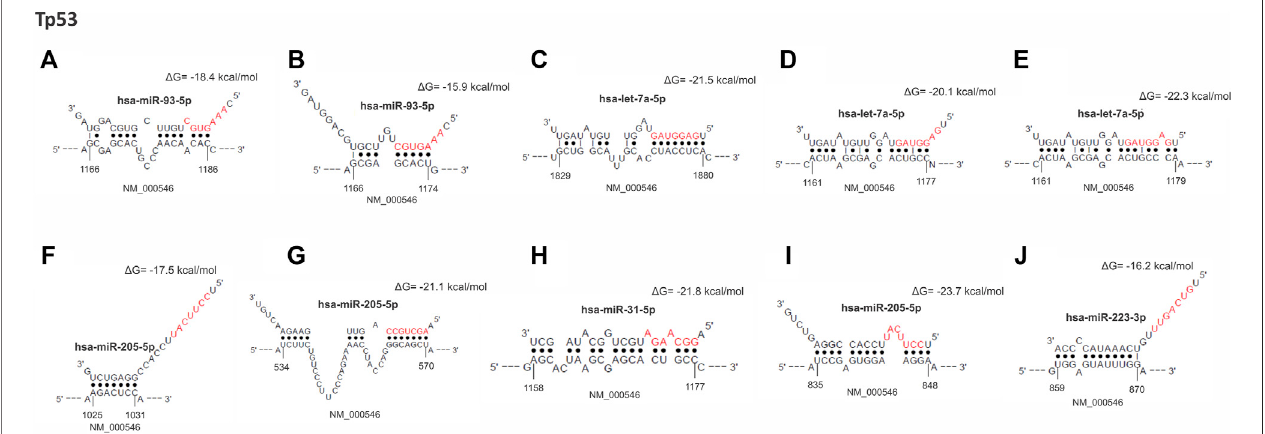
FIGURE 2 | From (A – J) , hybrid mRNA ( TP53 ) — miRNA upregulated. The upper and lower sequences represent the miRNA in the 3 ′ -5 ′ sense and 5 ′ -3 ′ sense hybridization sites in the mRNA, repectively. The numbers at the ends of the mRNA show the starting and ending position of the hybridization sites. Dots between the sequences indicate the paired nucleotides. Nucleotides in red mark the “ seed ” sequence in miRNA. The energy resulting from the hybridization was calculated by the RNA hybrid algorithm.